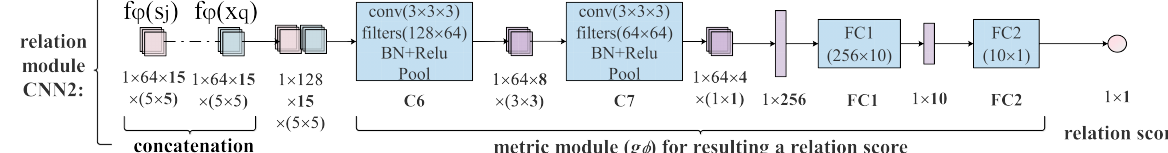
Figure 5. Architecture of the relation model to measure the similarity between deep features f ϕ ( s j ) and f ϕ ( x q ) .